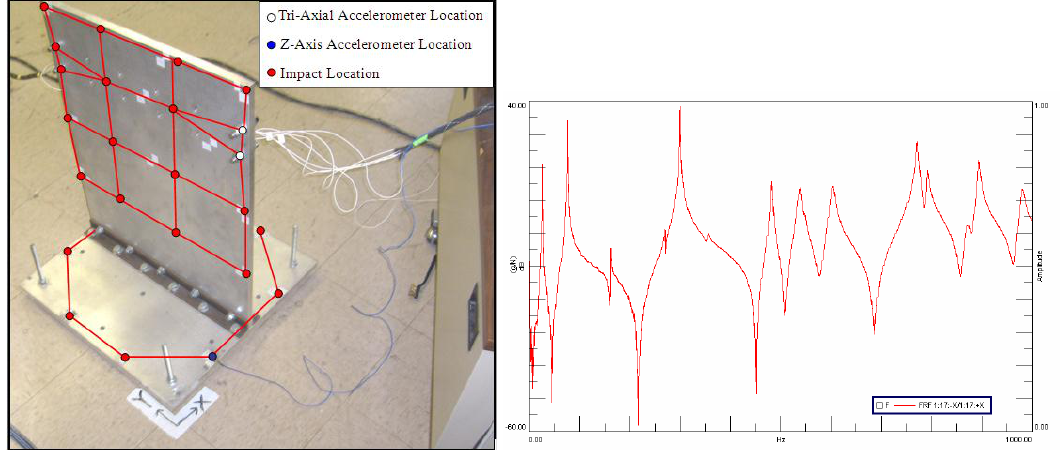
Fig. C-1. Upright test structure with measurement locations along with a typical drive point FRF.